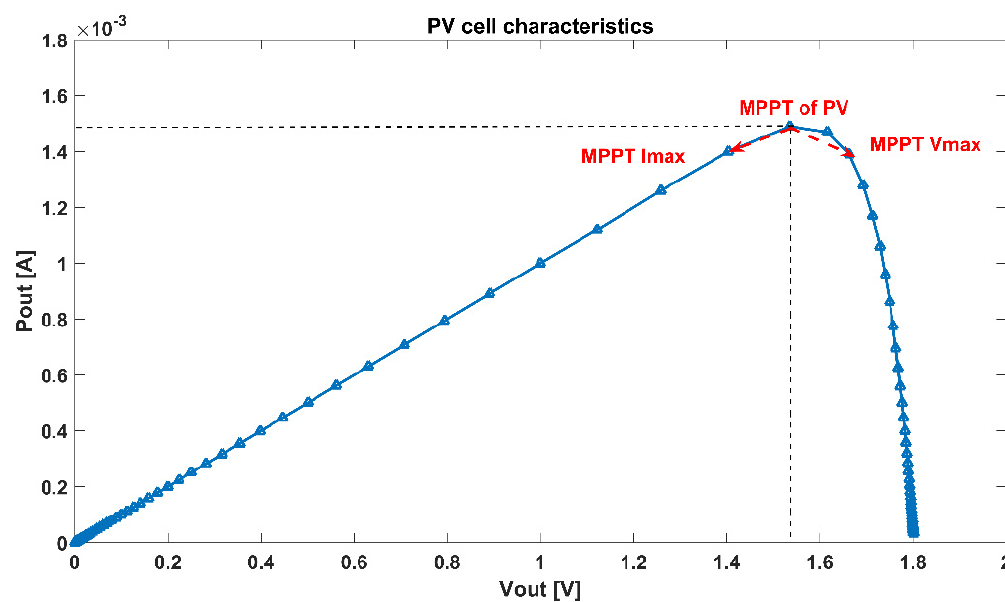
Figure 3. Schematic Curve Diagram of System MPPT.